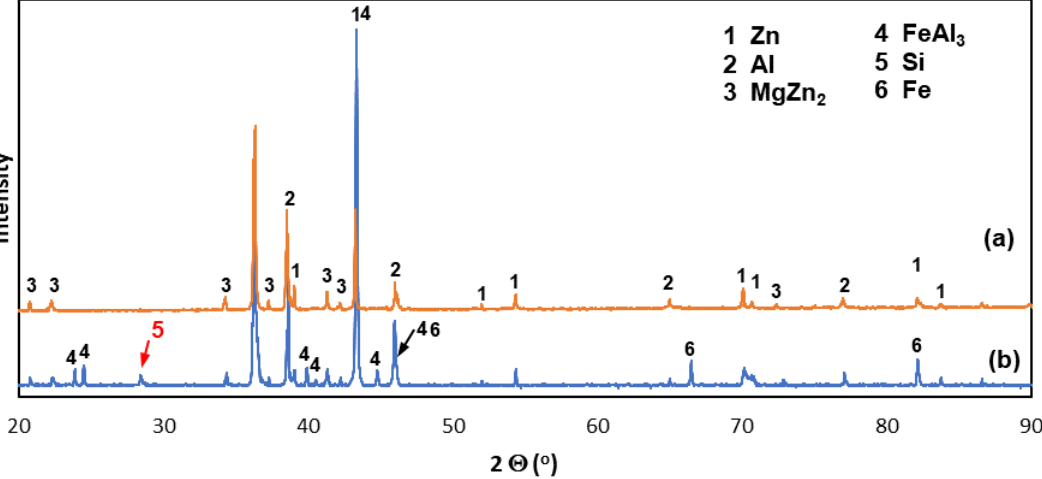
Figure 3. XRD spectra of the ZAMS coating: ( a ) from the flat ground surface of the outer layer of the coating and ( b ) from the bevel cut surface on the cross-section of the coating.